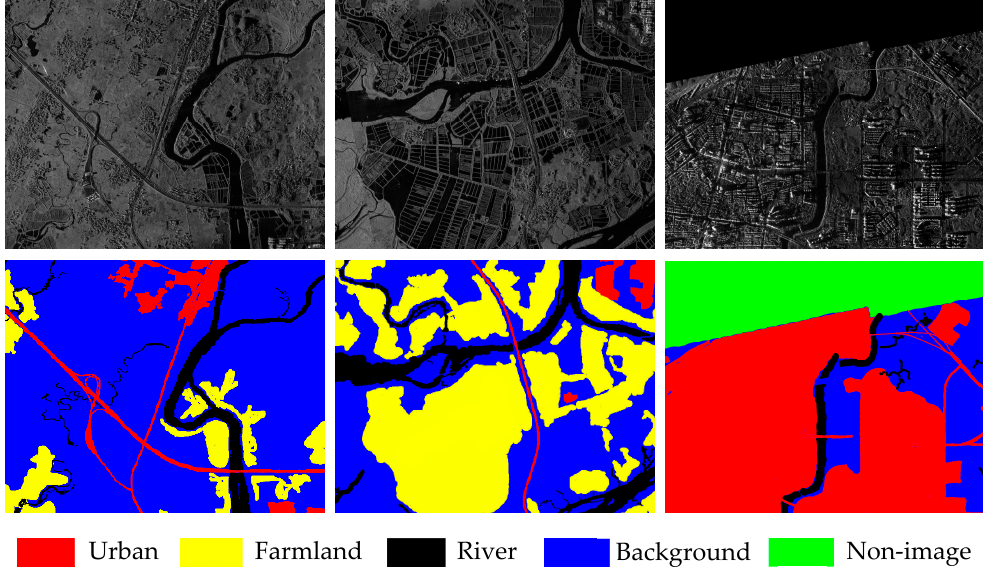
Figure 2. Part of images and the corresponding ground truth maps from the Fangchenggang dataset.